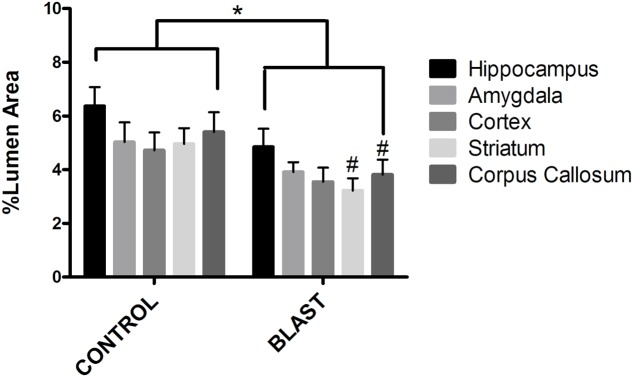
Blast exposure significantly reduced glycocalyx thickness in rats. Mean area of the glycocalyx quantified for each brain region and expressed as a percentage of the total capillary lumen area. Capillaries from blast exposed rats showed a significant reduction in glycocalyx area in the Corpus Callosum (3.811%), Striatum (3.217%), and Hippocampus (4.849%) compared to sham controls (5.403, 4.958, and 6.371%, respectively) Asterisk denotes global significance between sham blast and blast exposed capillaries (5.297% vs. 3.867%, Two way ANOVA, p = 0.0003); while pound symbol denotes significance between sham blast and blast exposed capillaries in identical brain regions.